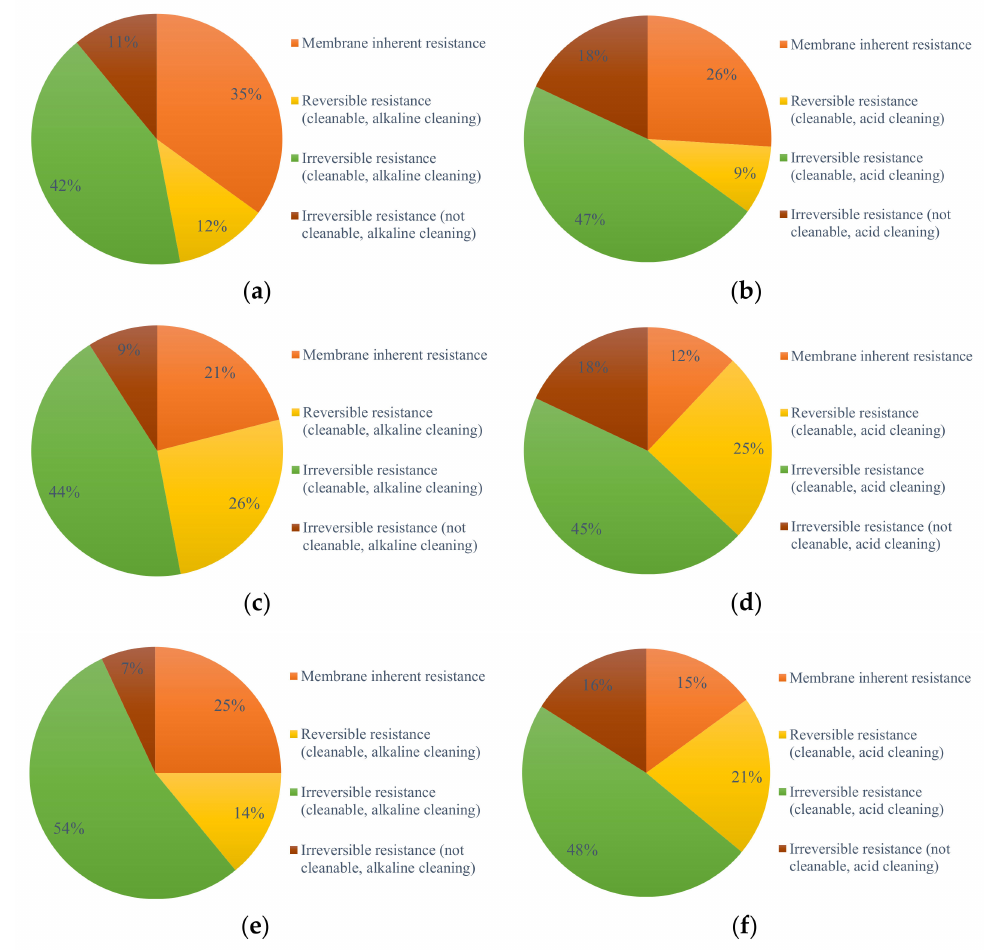
Figure 5. The ratio of the resistance of the membrane after cleaning: ( a ) direct UF filtration, alkaline cleaning; ( b ) direct UF filtration, acid cleaning; ( c ) L-UF, alkaline cleaning; ( d ) L-UF, acid cleaning; ( e ) S-UF, alkaline cleaning; and ( f ) S-UF, acid